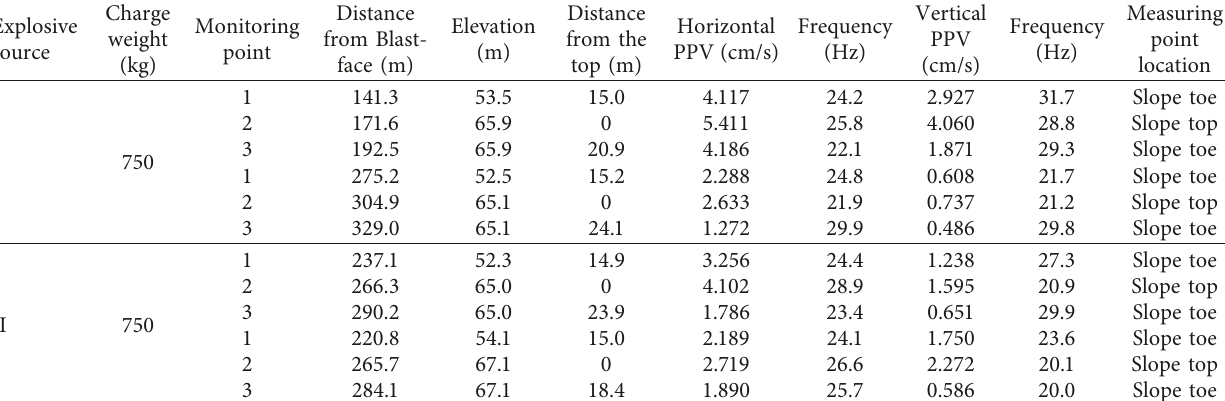
Table 2: Vibration monitoring results.